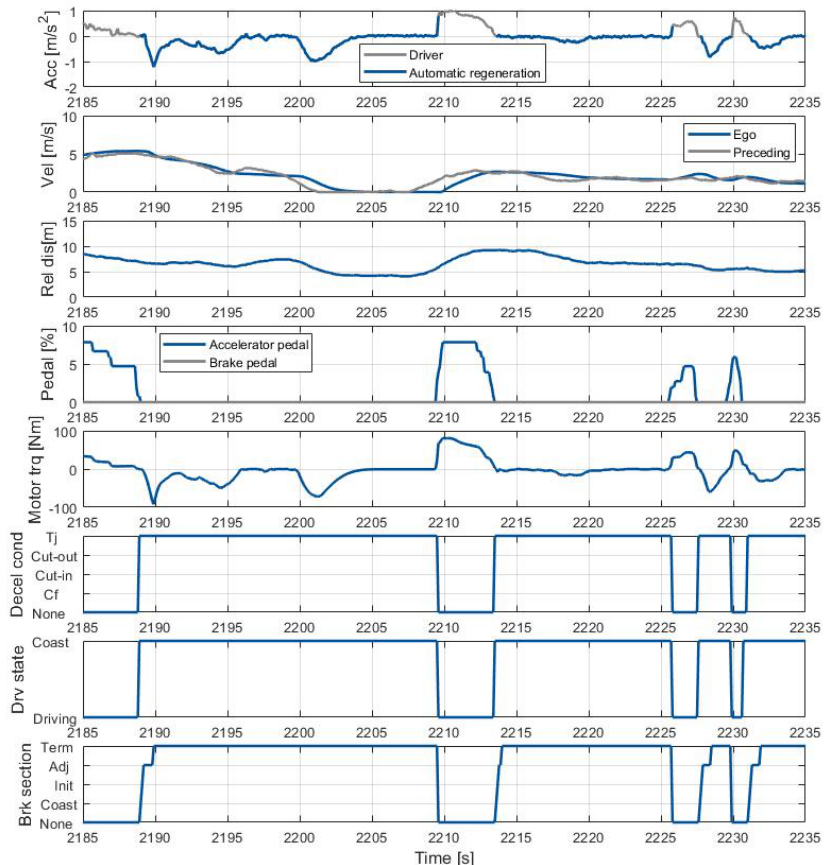
Figure 17. Test results in traffic jam situations.